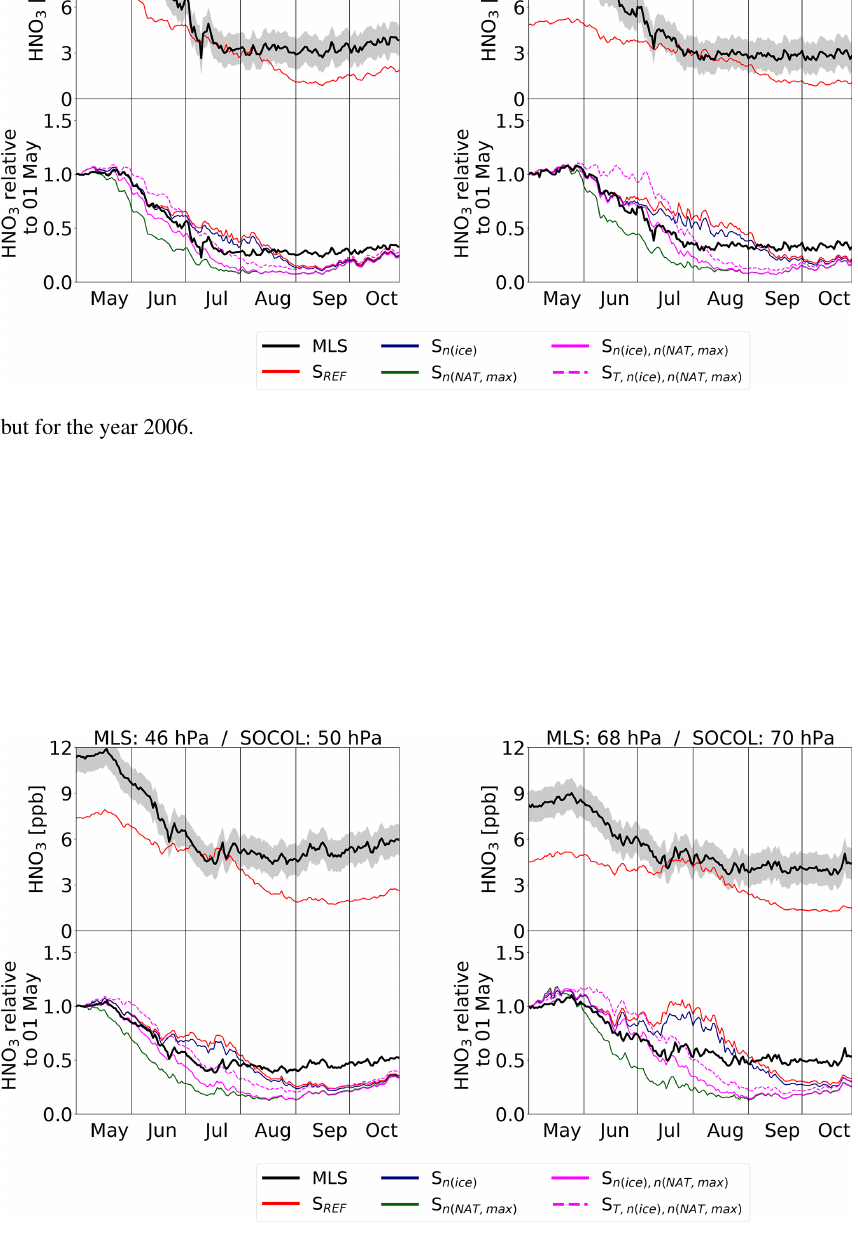
Figure A10. As Fig. 7 but for the year 2010.